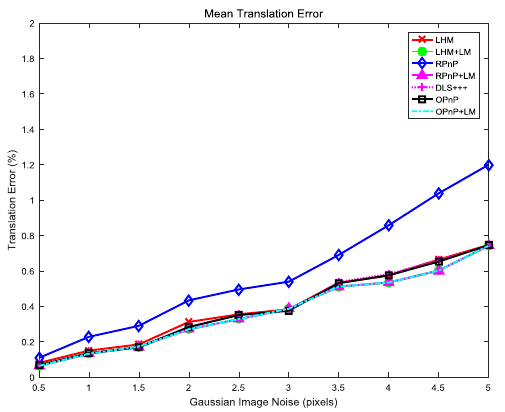
Figure 7. Mean translation error w.r.t. varying noise levels